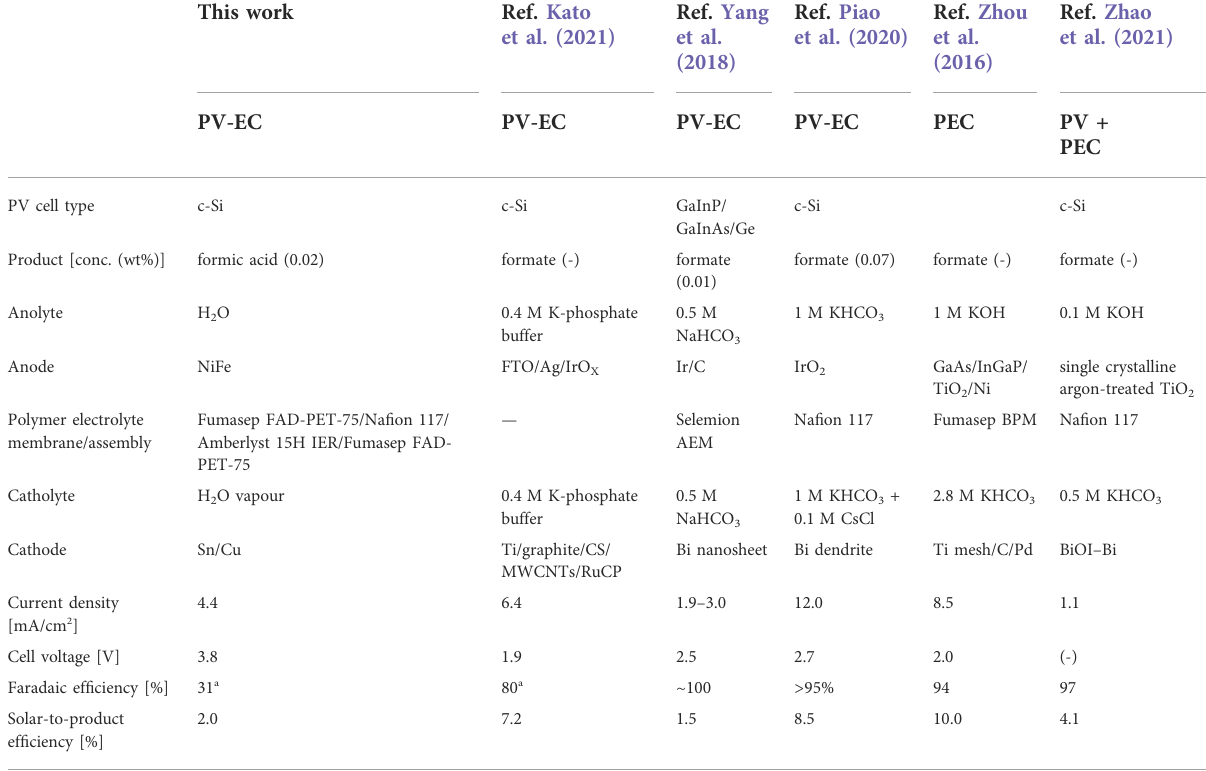
TABLE 1 Literature on solar CO 2 electrolysers producing formate, compared to this work on a solar CO 2 electrolyser producing dilute formic acid. This work Ref. Kato Ref. Yang et al. (2021) et